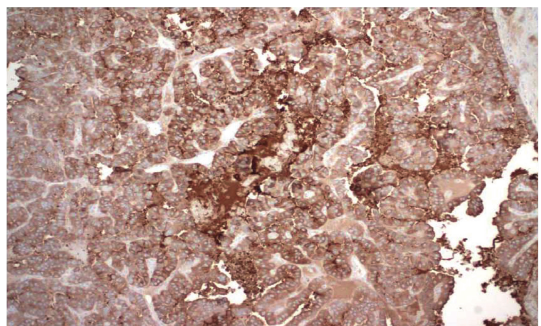
Figure 6: Immunohistochemistry for thyroglobulin was diffusely positive in tumor cells. This pattern confirms the tumor’s thyroid origin.